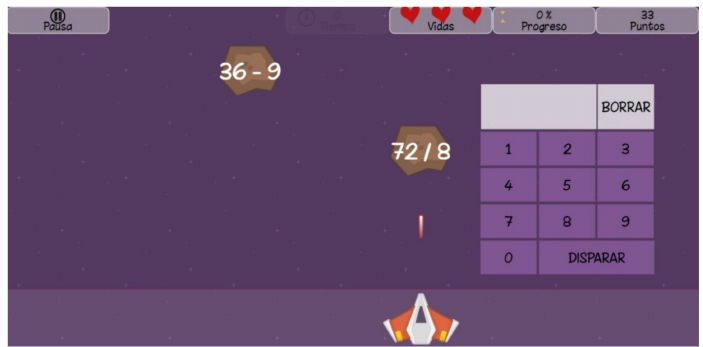
Figure 18. Mathematical Operations.